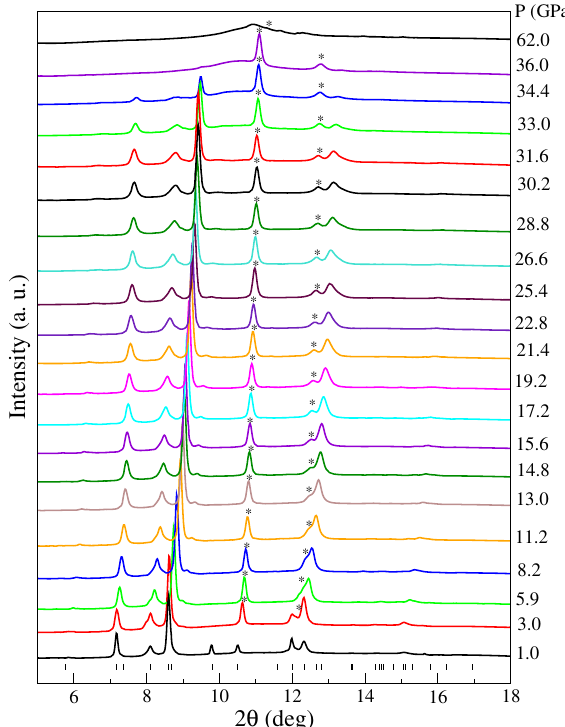
Fig. 1 Pressure-induced amorphization. XRD data taken at room temperature in run 2 under pressure up to 62 GPa. Bragg peaks based on the re fi nement with space group R3 m for 1 GPa data are shown in the tick marks. EuSn 2 P 2 starts transforming into